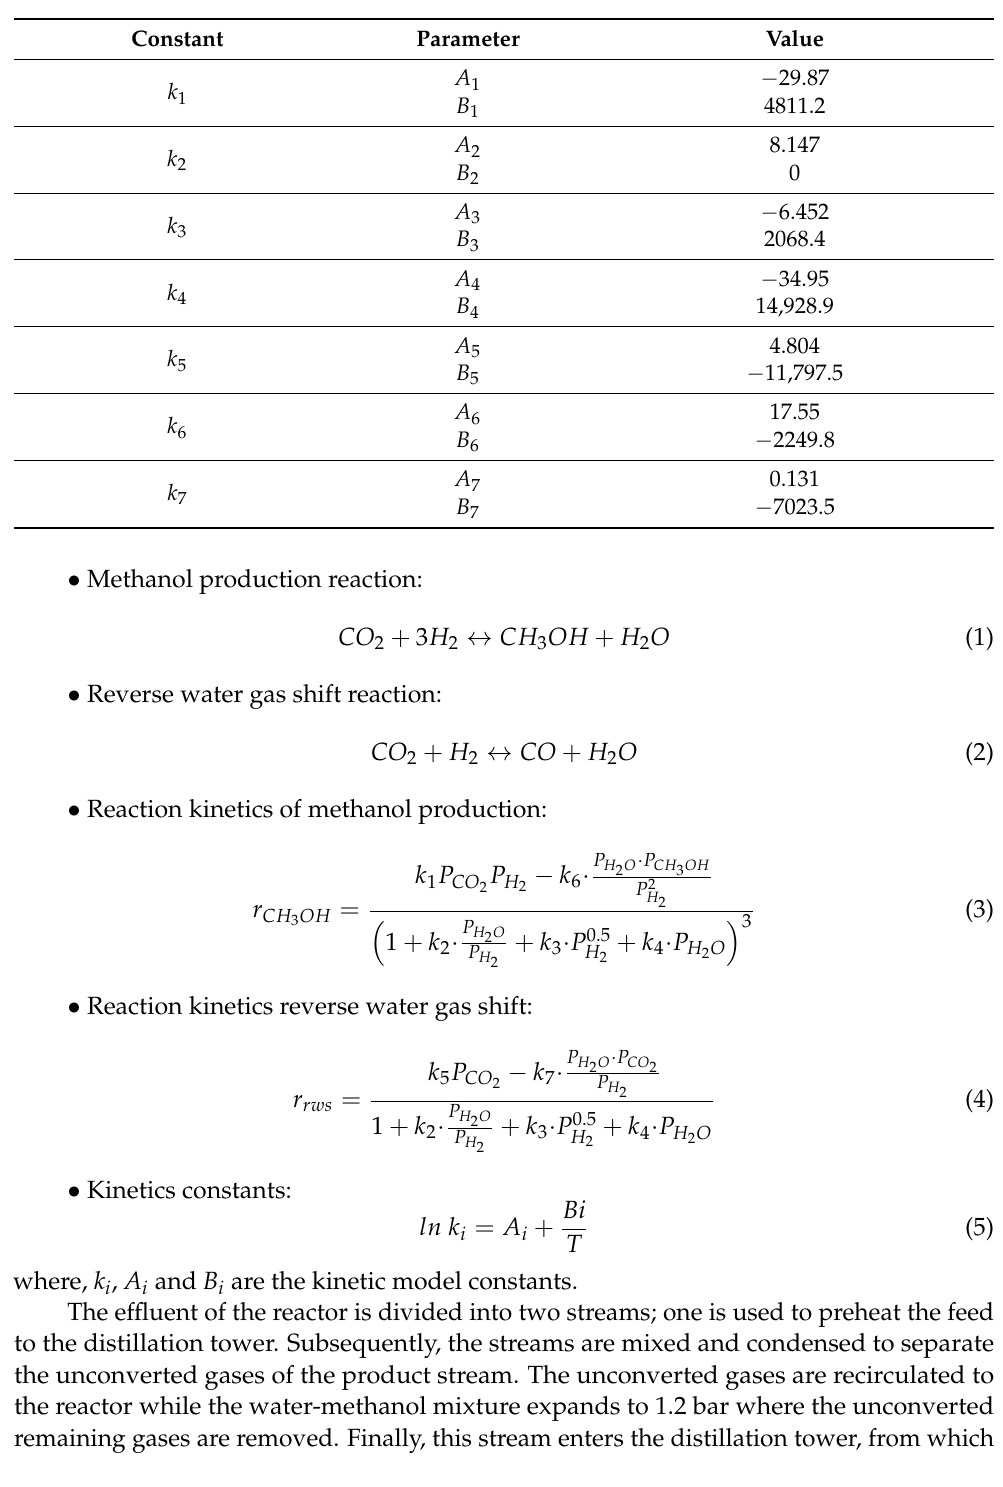
Table 3. Values of reordered kinetic parameters